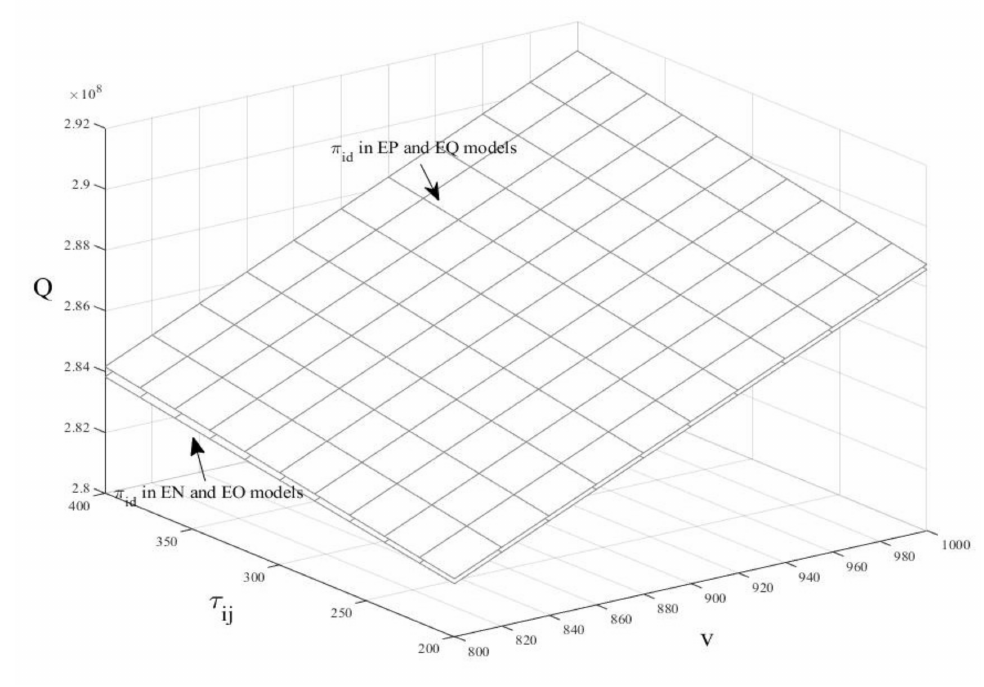
Figure 5. The impact of v and τ ij on π id